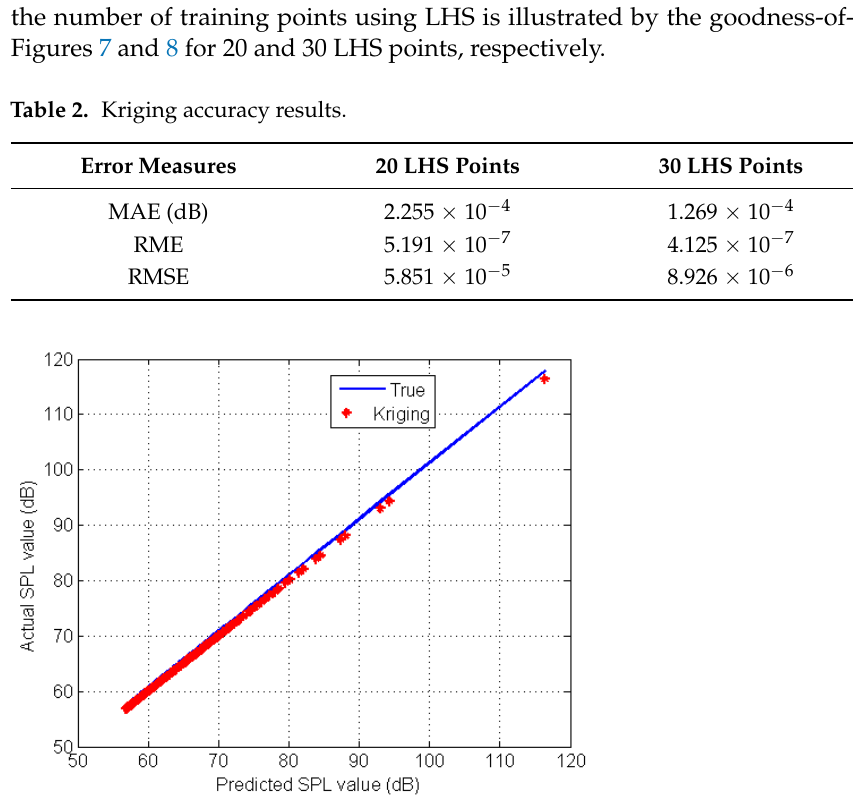
Figure 7. Cross-validation results of Kriging for maximum SPL with 20 LHS points.